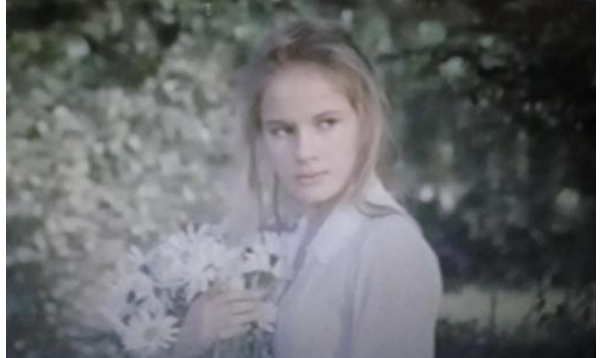
Figure 3: Bresson’s gentle woman (scene in the Bois de Boulogne)